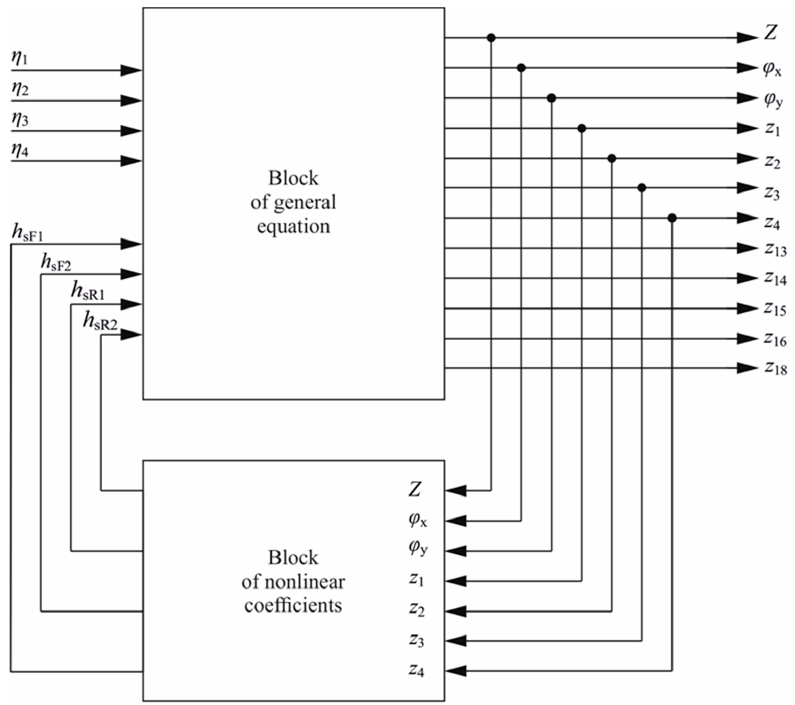
Figure 3. General structure of the dynamic model of the car.